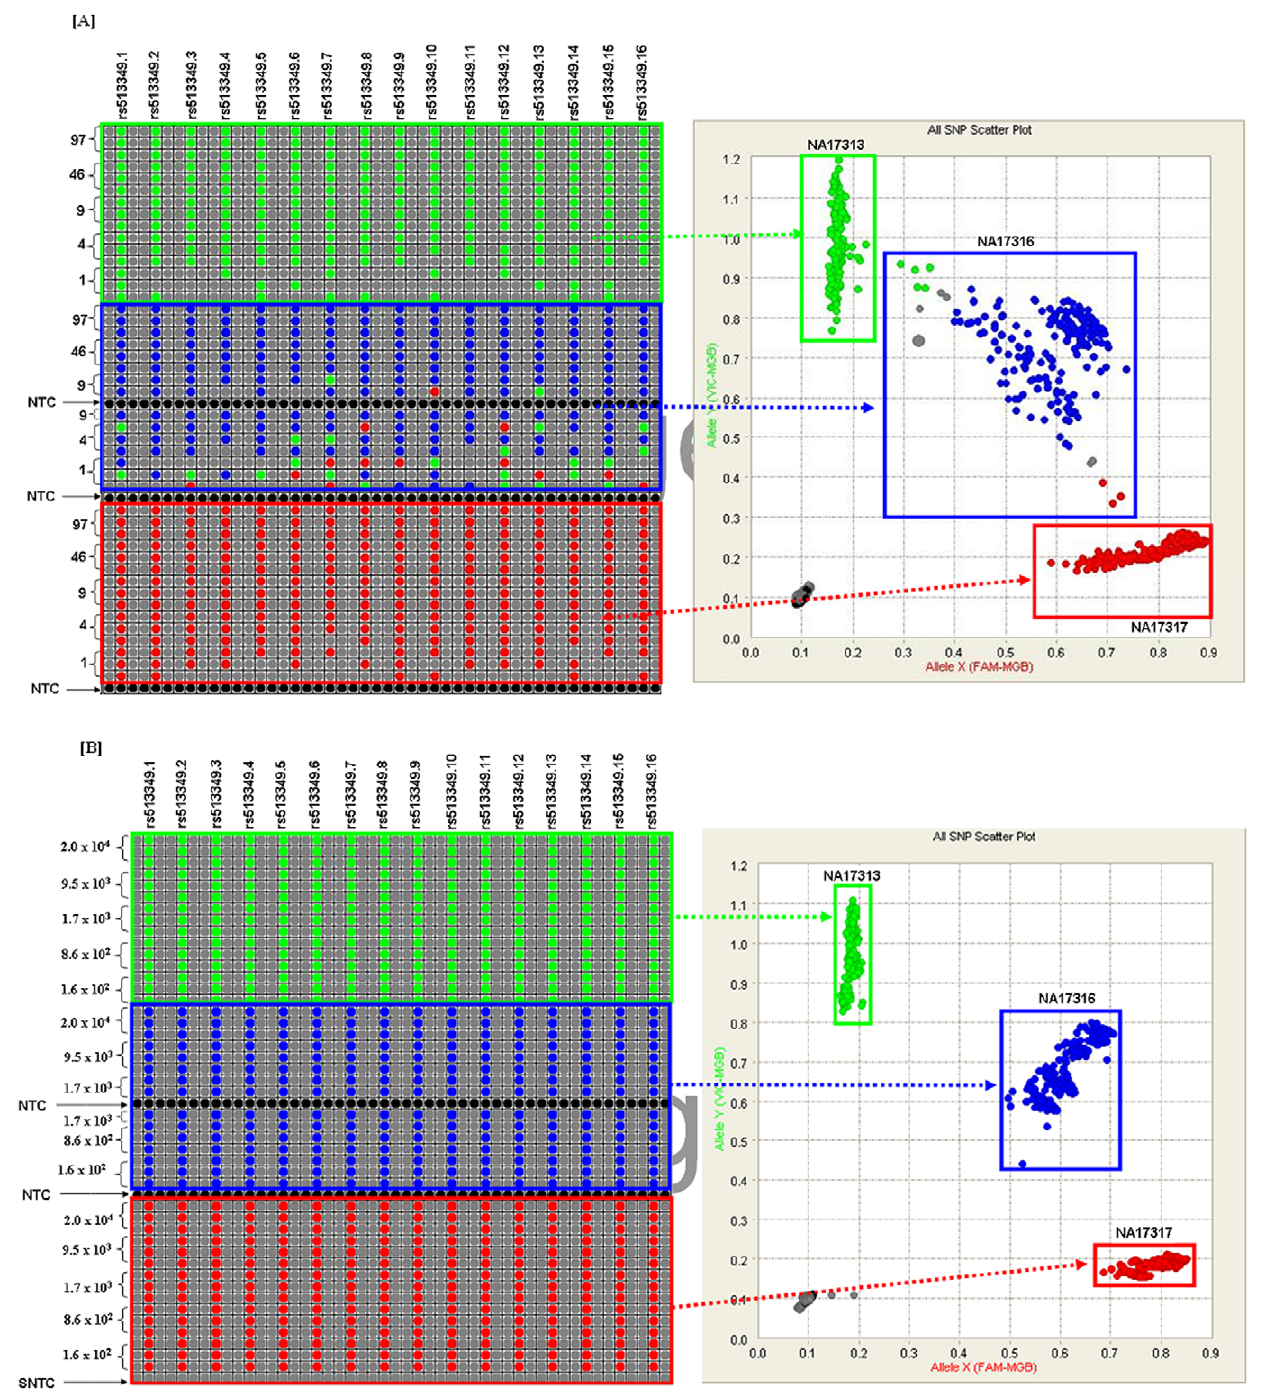
Figure 1. Effect of starting copy number on genotype call rate with and without STA. [A] and [B] Call map view and scatter plots of three human genomic DNA samples showing clustering ( pp -‘ red ’, qq -‘ green ’ and pq ‘ blue ’) for a single SNP with and without STA. Black and Grey colors correspond to No Calls. The reaction chambers contained different copies ranging, on average, from approximately 97 to 1 copies(y) without STA and 2.0 6 10 4 to 1.6 6 10 2 copies with STA. SNP-GT assay (rs513349) was loaded into sixteen separate assay inlets evenly spaced across the 48.48GT array. The remaining inlets were loaded with a NPC as stated in the Methods section.